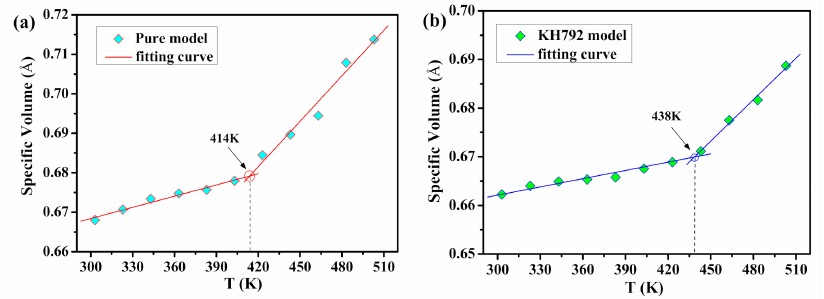
Specific volume–temperature curves of the models: ( a ) unmodified model and ( b ) KH792